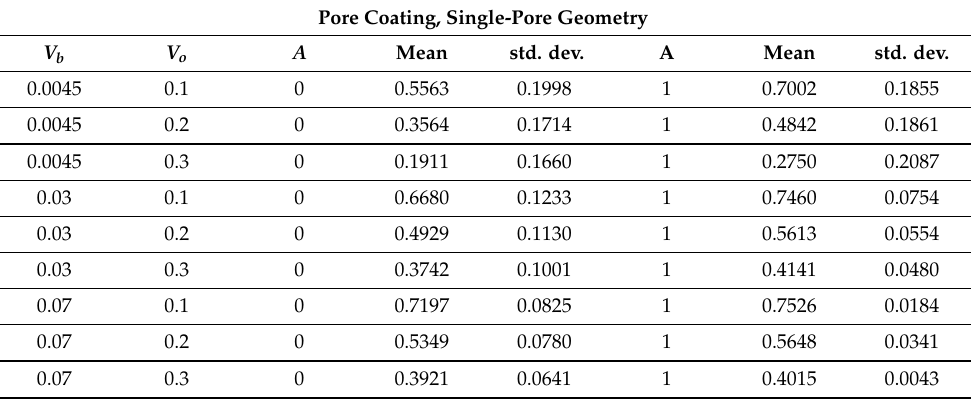
Table 7. Sensitivity of the probability distribution of K ( i ) / K 0 to the simulation parameters V b and A for the geometries D 0 obtained with DNS for pore-coating scenarios. The values K presented here correspond to three selected vales of the relative volume V o = | D o | from the set { 0.1,0.2,0.3 } . | D v | Pore Coating, Single-Pore Geometry std. dev. std.